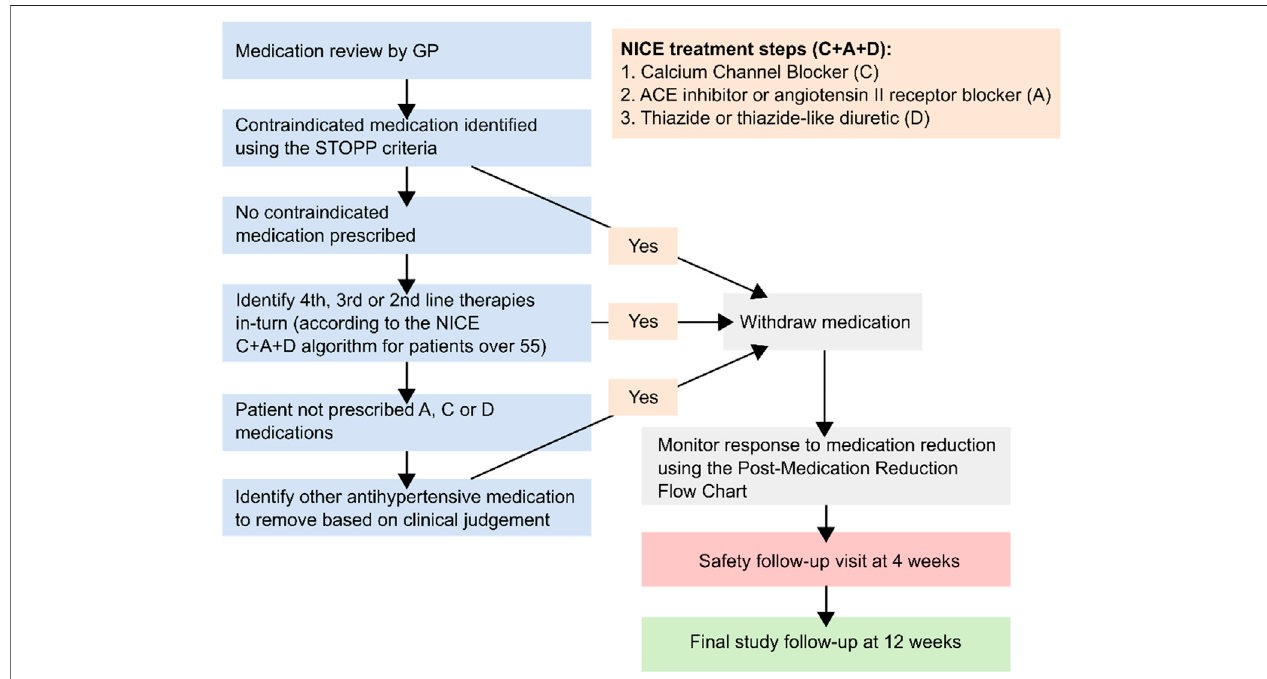
FIGURE1| Medicationreductionalgorithmgiventogeneralpractitionersparticipating intheOptimizetrialNICE (cid:2) NationalInstituteforHealthandCareExcellence. Contraindicated medications described in the STOPP START criteria (Gallagher et al., 2008). Figure adapted from previous publications about this trial (Sheppard et al., 2018; Sheppard et al.,